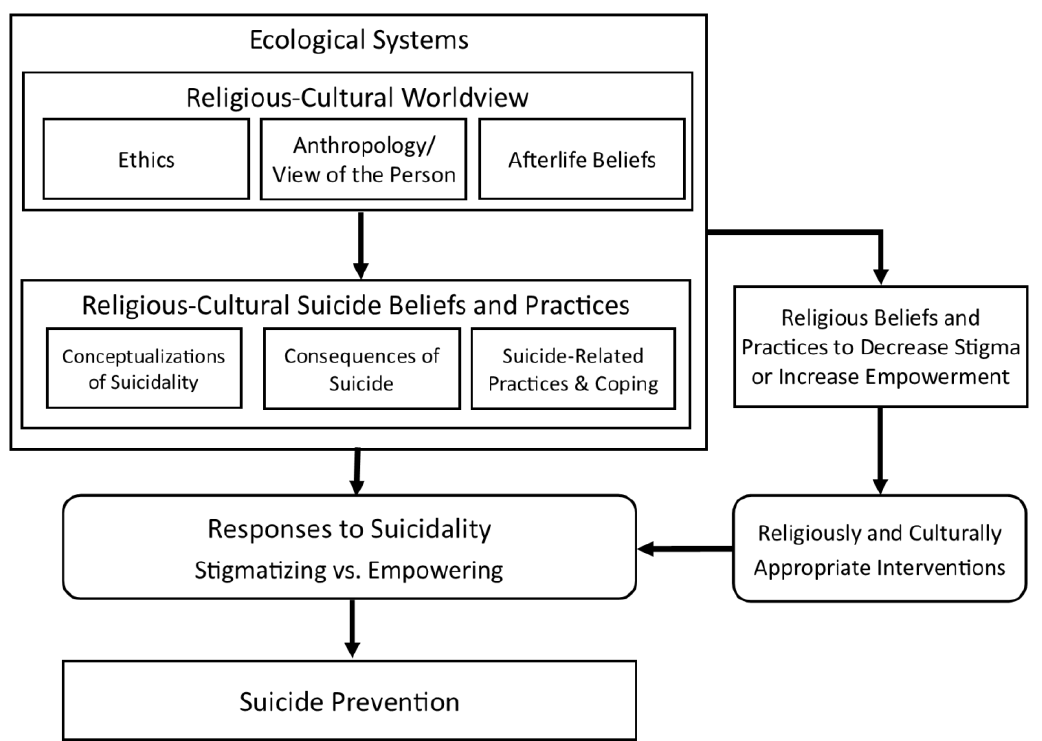
Figure 2. Action research framework for religious stigma of suicide.